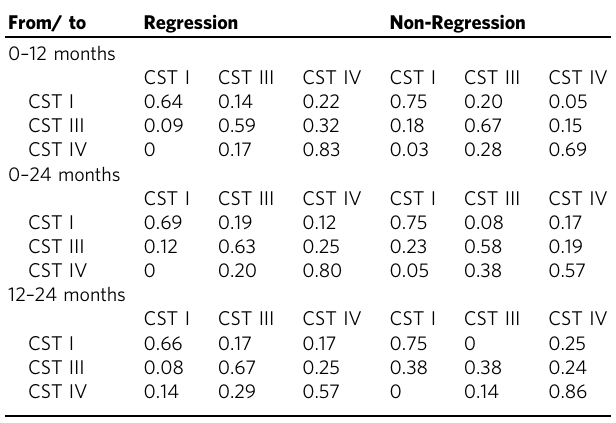
Table 3 Markov modelling to assess transition probabilities of VMB dynamics among non-regressors and regressors at 0 – 12, 0 – 24 and 12 – 24 months. From/